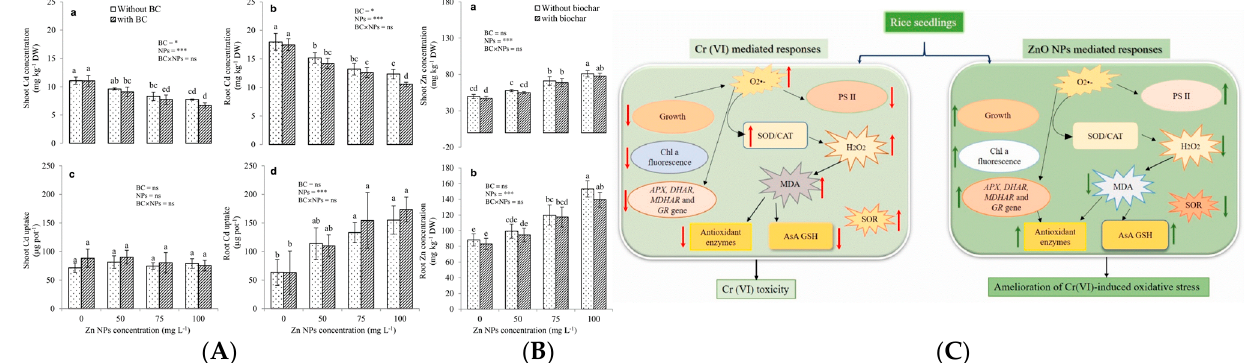
Figure 8. ( A ) Concentrations and total uptake of Cd in the shoots and roots of rice treated with biochar and ZnO NPs. (a) Cd concentrations in shoots; (b) Cd concentrations in shoots; (c) Cd uptake by shoots; (d) Cd uptake by roots. Values are means of four replications and bars represent standard deviation. Different letters demonstrate significant differences among treatments. In figures, ns = non-significant; * = significant at 0.05, ** =significant at 0.01, and *** = significant at 0.001 levels; ( B ) Concentrations of Zn in the shoots and roots of rice treated with biochar and ZnO NPs. (a) Zn concentrations in shoots; (b) Zn concentrations in shoots. Values are means of four replications and bars represent standard deviation. Different letters demonstrate significant differences among treatments. In figures, ns = non-significant; * = significant at 0.05, ** = significant at 0.01, and *** = significant at 0.001 levels. Reprinted with permission from Ref. [66]. 2019, Springer-Verlag; ( c ) probable model for Cr(VI)-induced stress and ZnO NPs’ action in response to Cr(VI) toxicity in rice seedlings. Reprinted with permission from Ref. [70]. 2022, Elsevier.